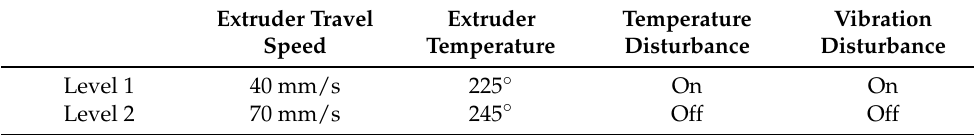
Table 5. Setting Variables in the Experiment